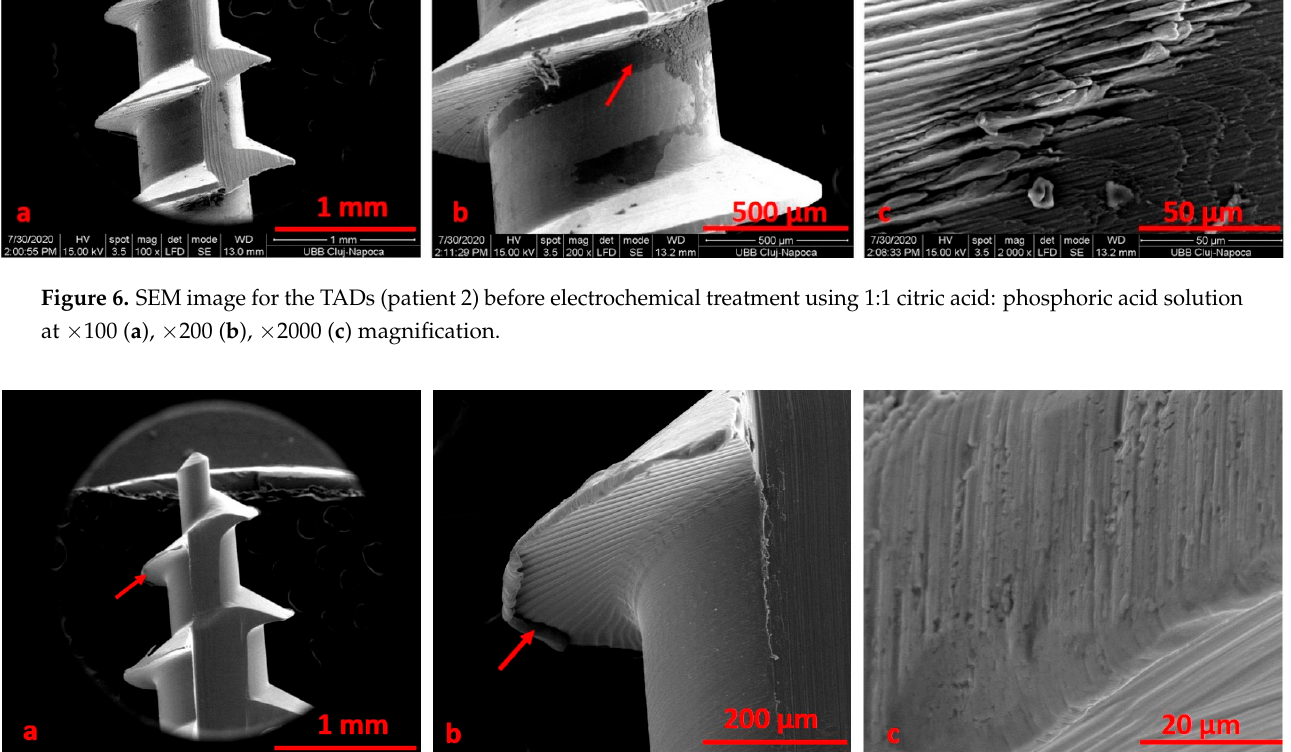
Figure 7. SEM image for the TADs (patient 2) after electrochemical treatment using 1:1 citric acid: phosphoric acid solution at × 100 ( a ), × 500 ( b ), × 5000 ( c ) magnification.